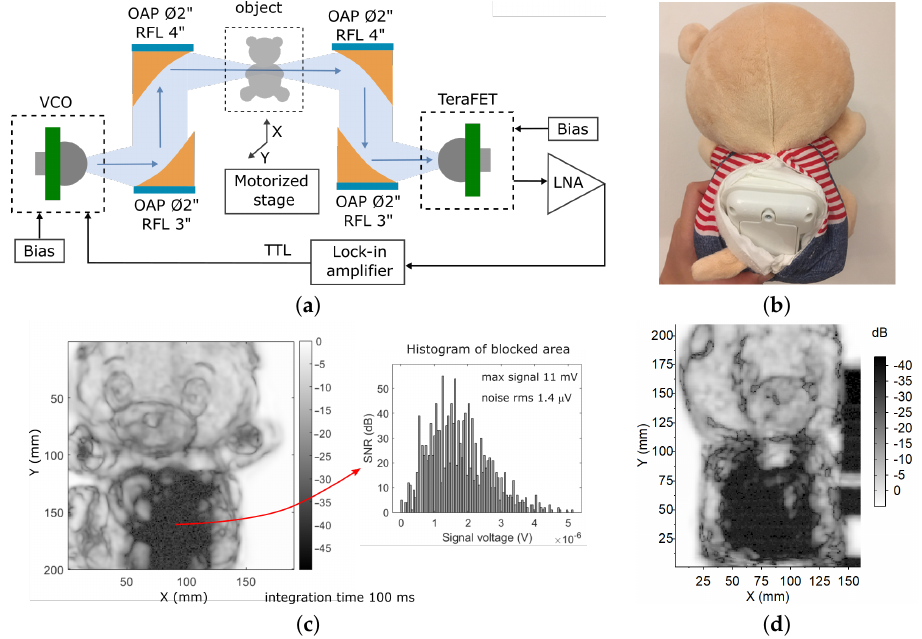
Figure 13. ( a ) Terahertz raster imaging system. ( b ) The photo of the sample. ( c ) THz image of the sample recorded in the setup with VCO1 and the Si lens of 4 mm diameter. Inset: a histogram of recorded values in a blocked region allowing to estimate the noise voltage. ( d ) The THz image of the same sample was recorded with the setup with more powerful VCO3 and the Si lens of 12 mm diameter. RFL, reflected focal length; OAP, off-axis parabolic mirror; LNA, low-noise amplifier. The two-dimensional raster-scan images of the teddy bear are shown in Figure